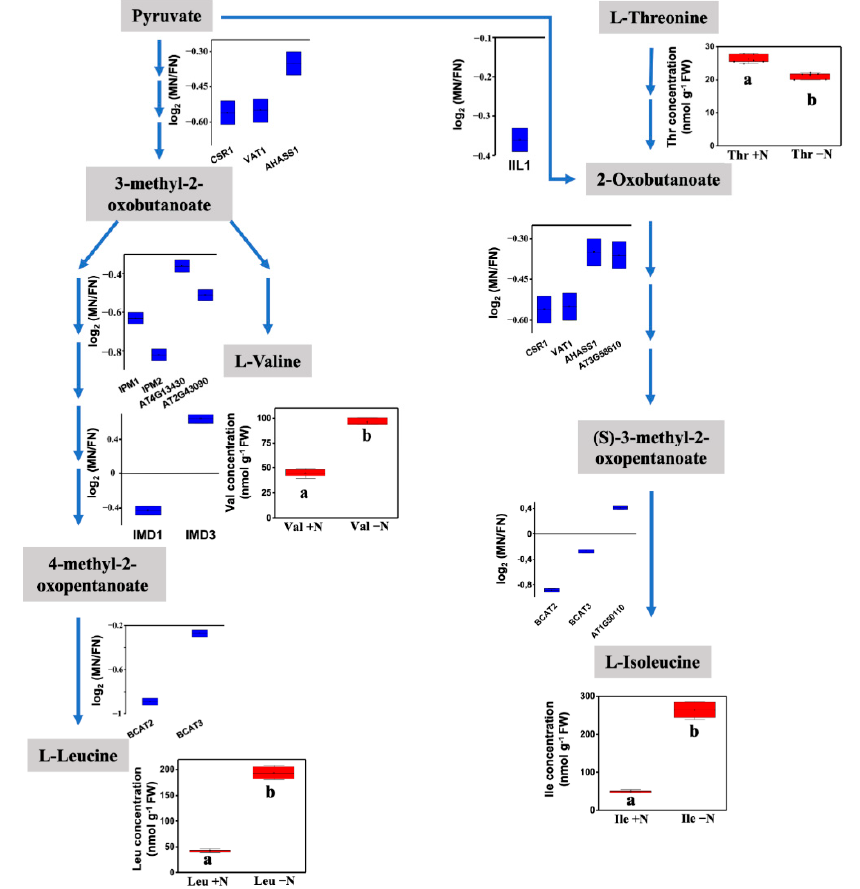
Figure 7. Schematic of branched-chain amino acid metabolism. The blue box plot shows the quantified (log 2 -fold change MN/PN) level of persulfidation of the enzymes involved in the process detected in N-starved samples compared with N-sufficient samples. The red box plot shows the amino acid concentration measured in N-deprived (-N) or N-sufficient samples (+N) (n = 4). Different letters below the bars indicate significant differences with p < 0.01 (One-way ANOVA, post-hoc Tukey adjustment).